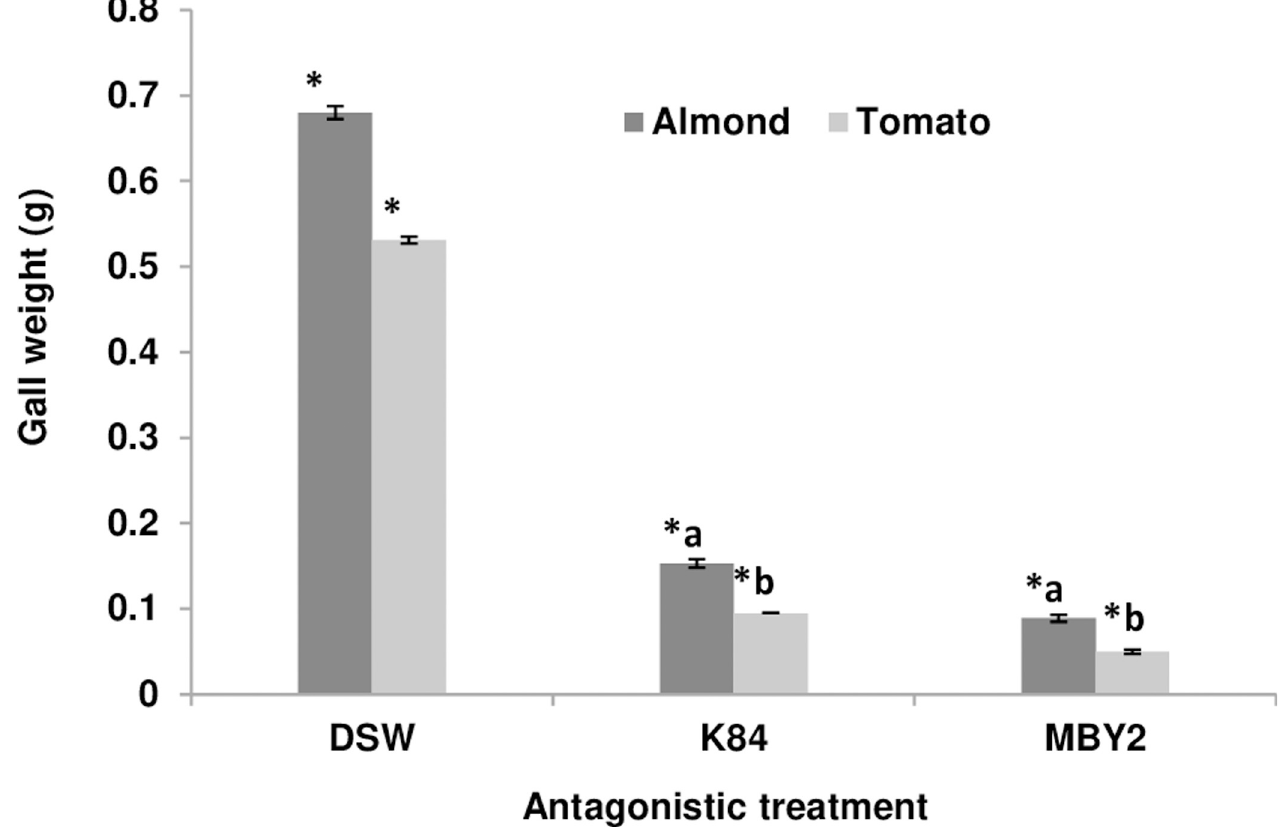
Fig 7. Effect of the antagonistic treatment with B . velezensis isolate MBY2 on the weight of galls induced by A . fabrum C58 on tomato and almond plants. Stems of tomato and almond plants were pre-infected with A . fabrum C58 and subsequently treated with B . velezensis isolate MBY2, with A . radiobacter biocontrol strain K84 as positive or with distilled sterile water (DSW) as negative control. Gall weight was determined 70 days after the treatment. Error bars show the variation between three biological replicates. The asterisk ( � ) designates a significant difference compared to EDS p < 0.05. Letters “a” and “b” denote that there was no significant difference between samples with the same letter (p >